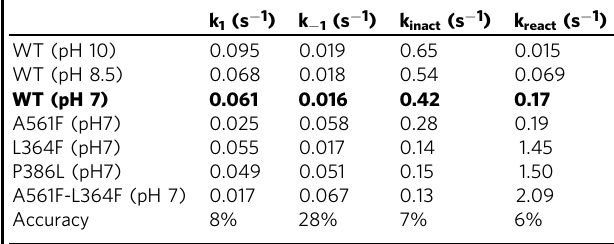
Table 1 Values of k 1 , k -1 , k inact , k react (the latter at − 0.196 V, all at 5 °C) for CbA5H WT and